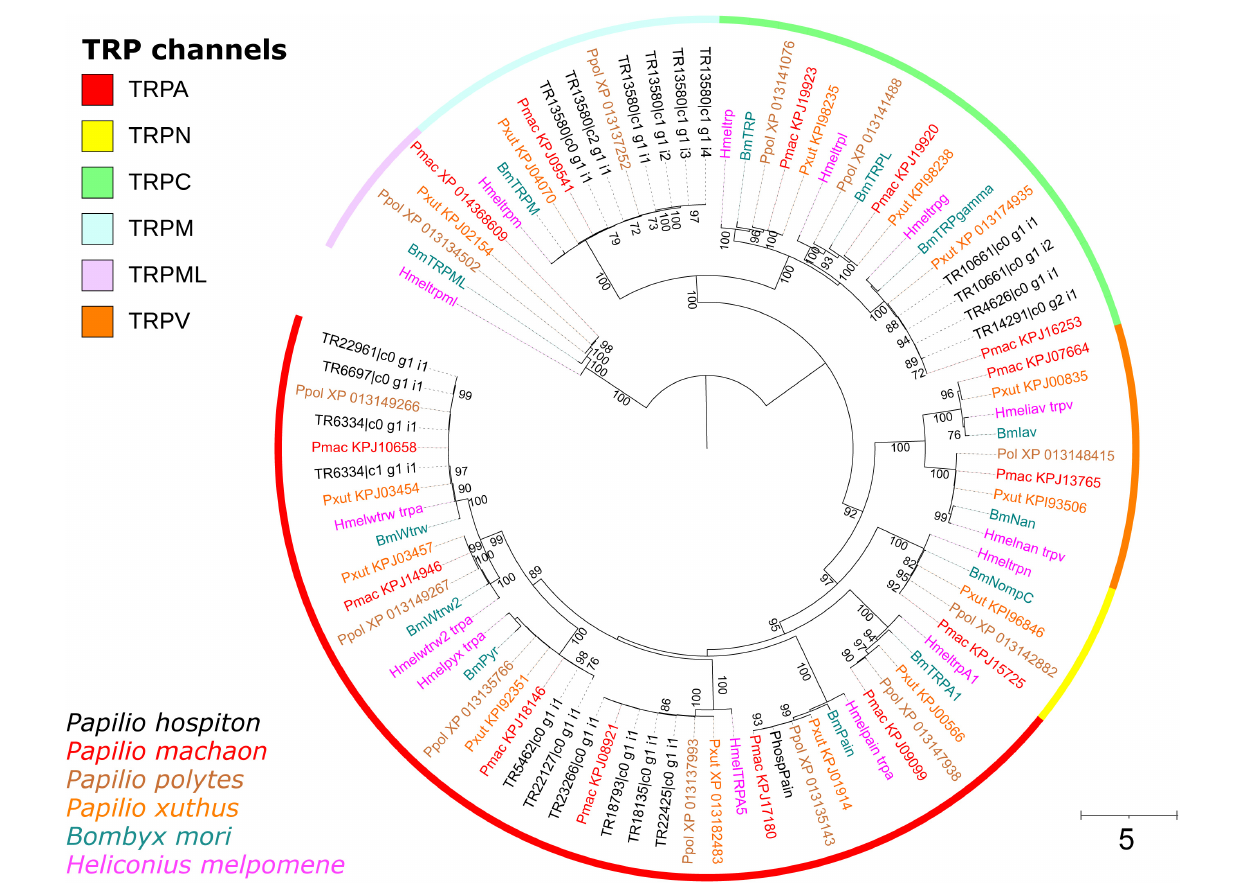
FIGURE 4 | Phylogeny of P. hospiton maxilla-expressed transient receptor potential channels (TRPs). A maximum-likelihood tree was built with TRP repertoires from automatically annotated genomic datasets of P. machaon , P. xuthus , and P. polytes (Li et al., 2015) using RAxML. Manually curated genomic datasets of B. mori (Matsuura et al., 2009), and H. melpomene (Macias-Muñoz et al., 2019) are included. For PhospPain we used the full-length coding sequence amplified from cDNA instead of the two fragments obtained from RNA-seq. Branch lengths are scaled by the number of nucleotide substitutions per site. Bootstrap values refer to 500